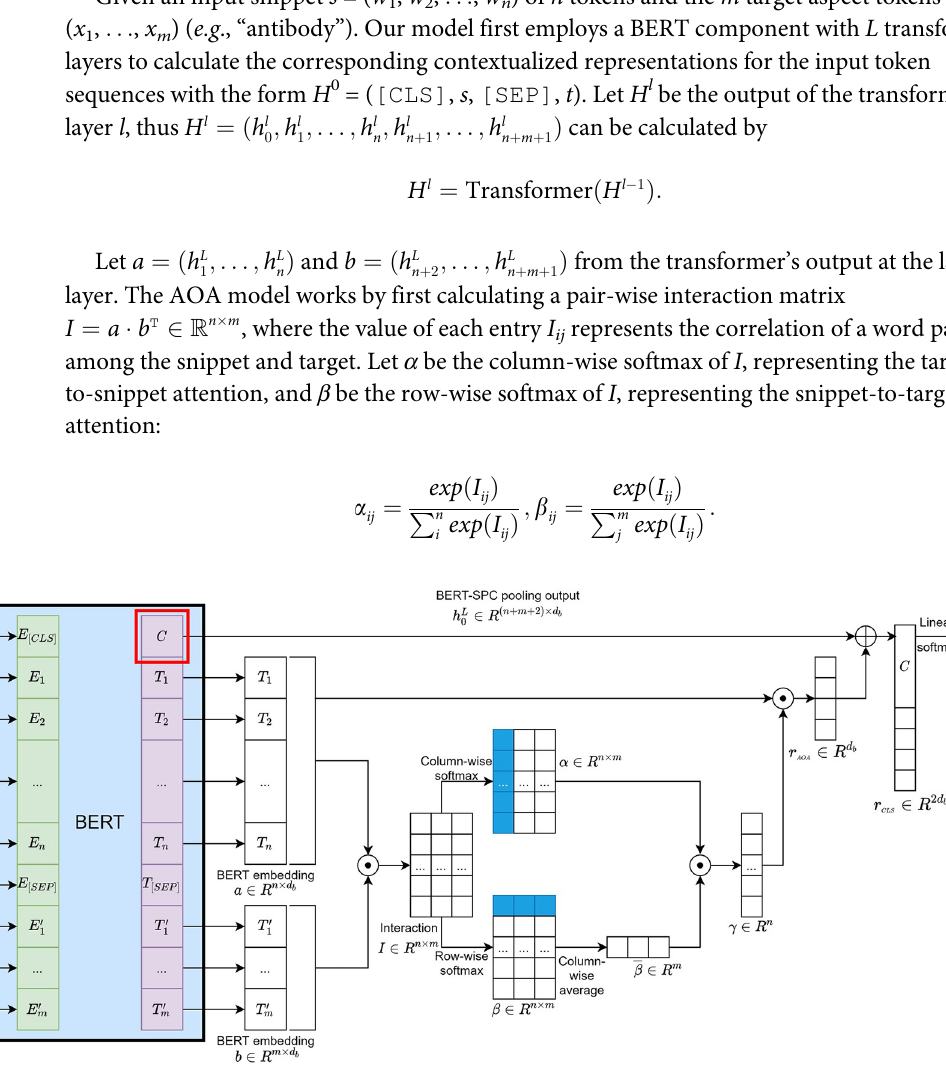
Fig 2. A schematic diagram of the neural network architecture of (ABSA) 2 for classifying antibody specificity snippets. (ABSA) 2 is an attention- over-attention model (AOA) based on ABSA [18] but with a transformer (left) as its input word embedding layer. (ABSA) 2 takes a snippet and an aspect token “antibody” as the input to classify the snippet into one of the specificity